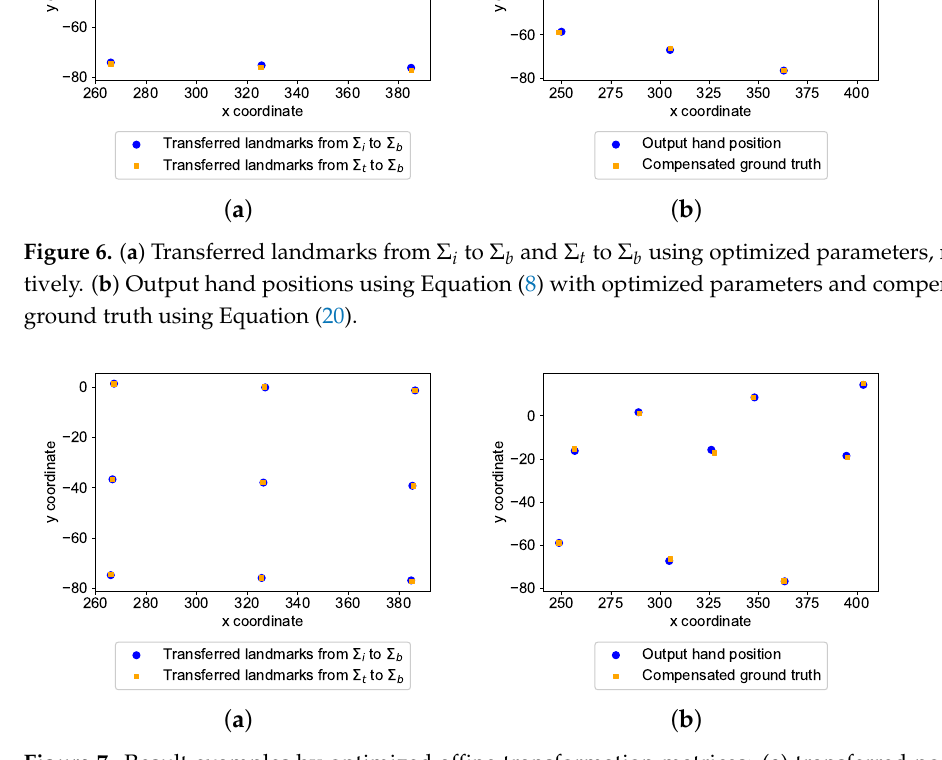
Figure 7. Result examples by optimized affine transformation matrices: ( a ) transferred positions of black dots. ( b ) Output hand positions using Equation (8) and compensated ground truth using Equation